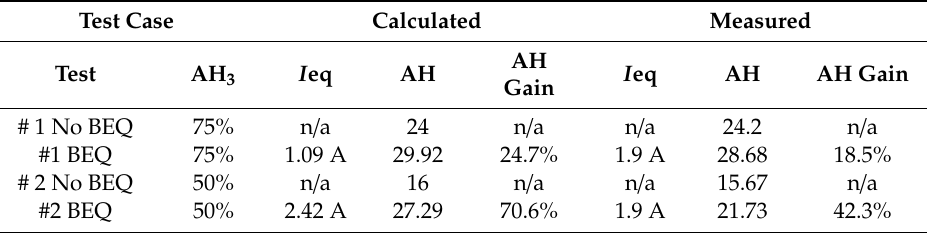
Table 1. Calculated and measured results for Tests #1 and